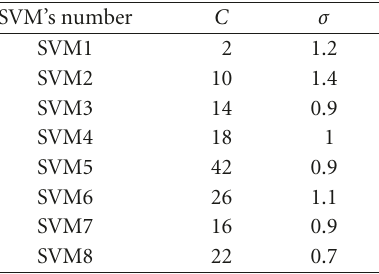
Table 6: Optimum parameters of SVMs.